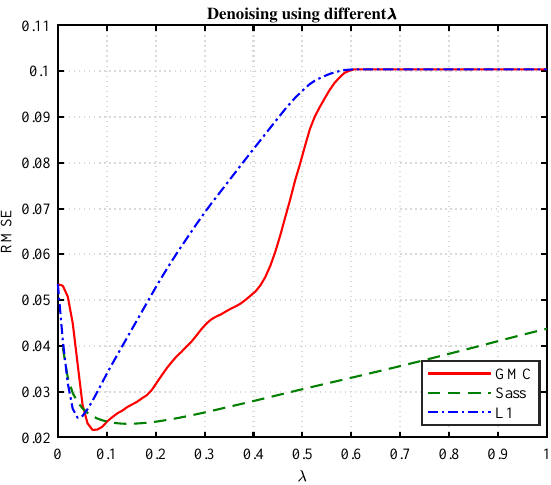
Figure 10. RMSE versus λ with γ = 0.8.